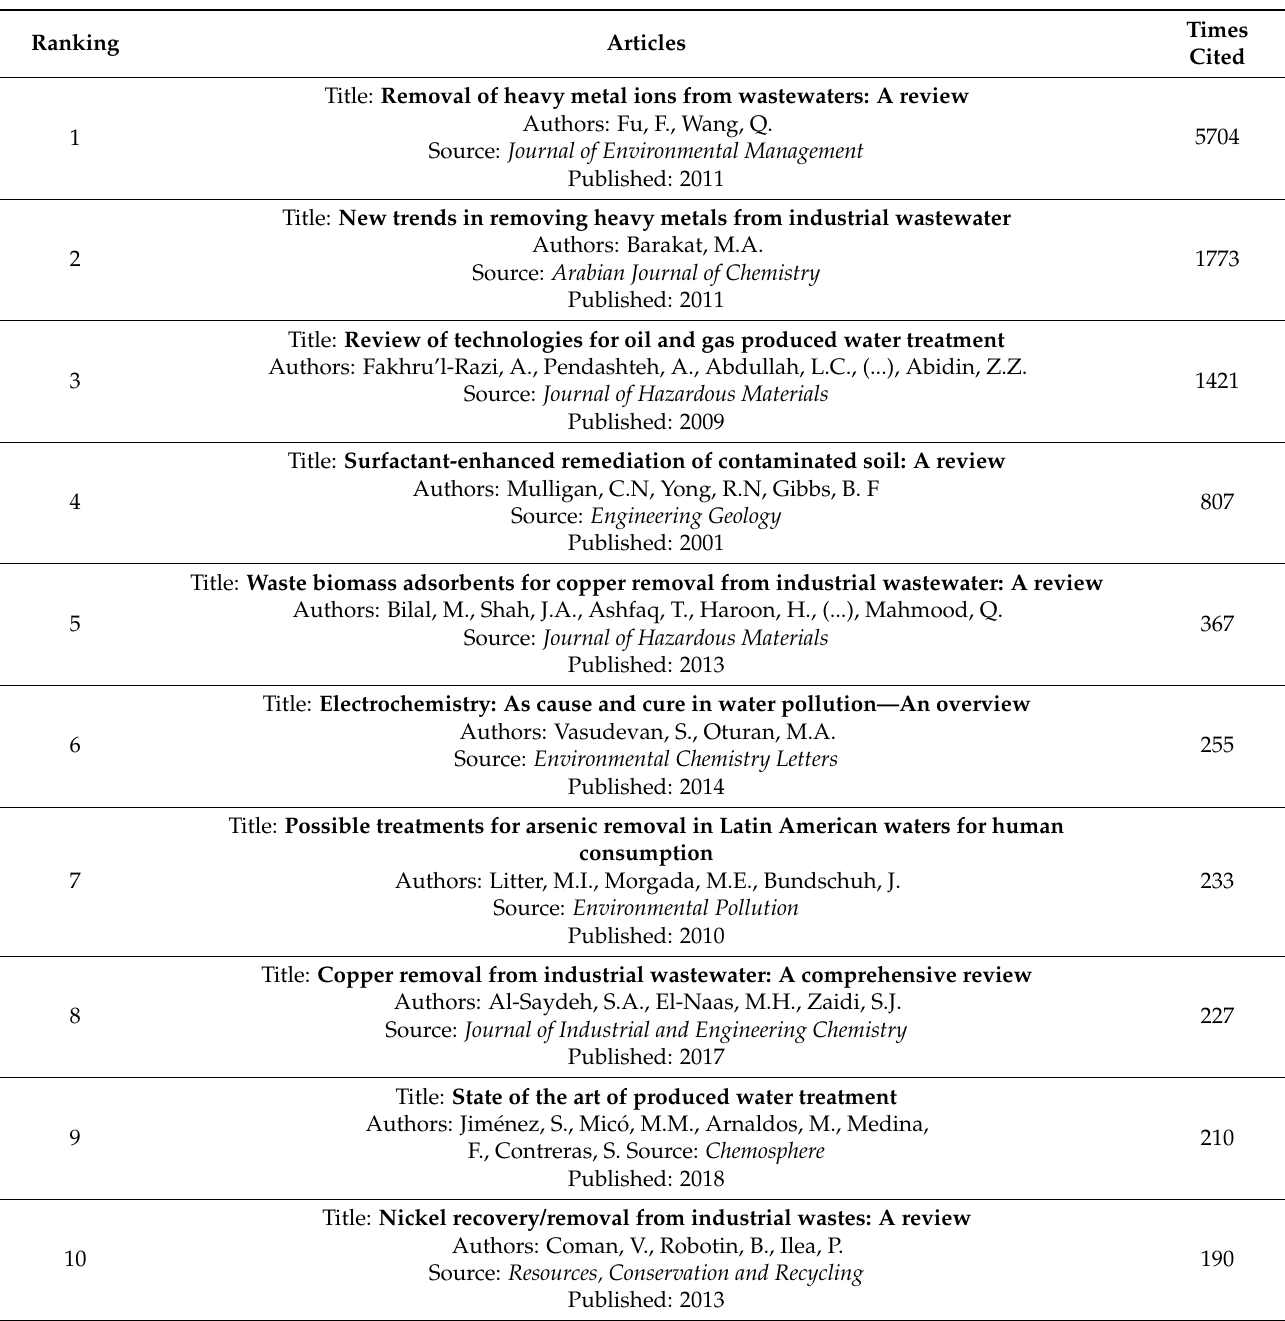
Table 7. The top 10 most cited